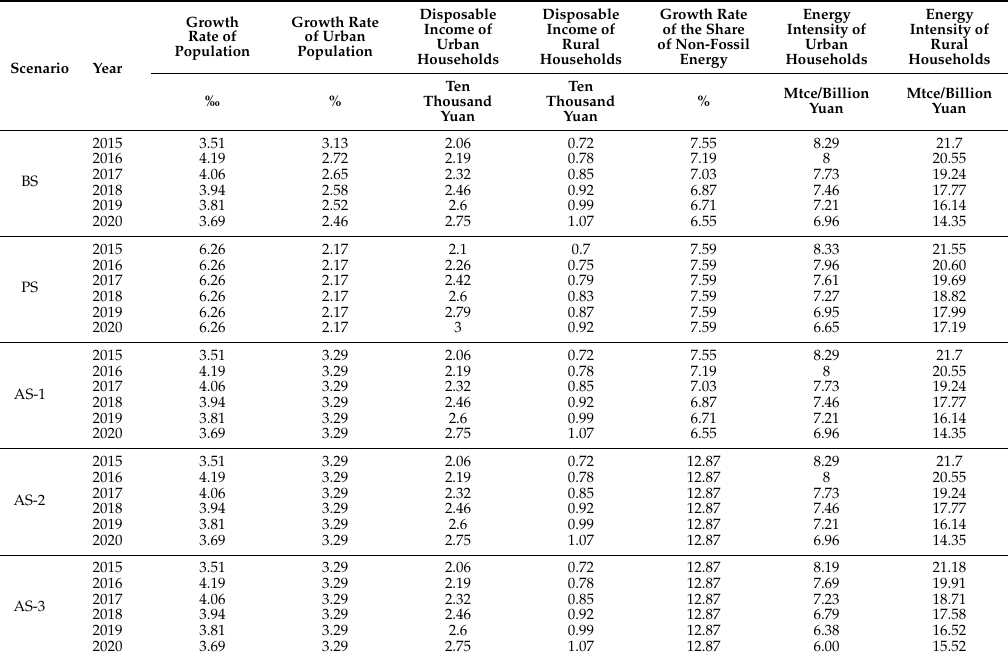
Table 3. Household CO 2 emission